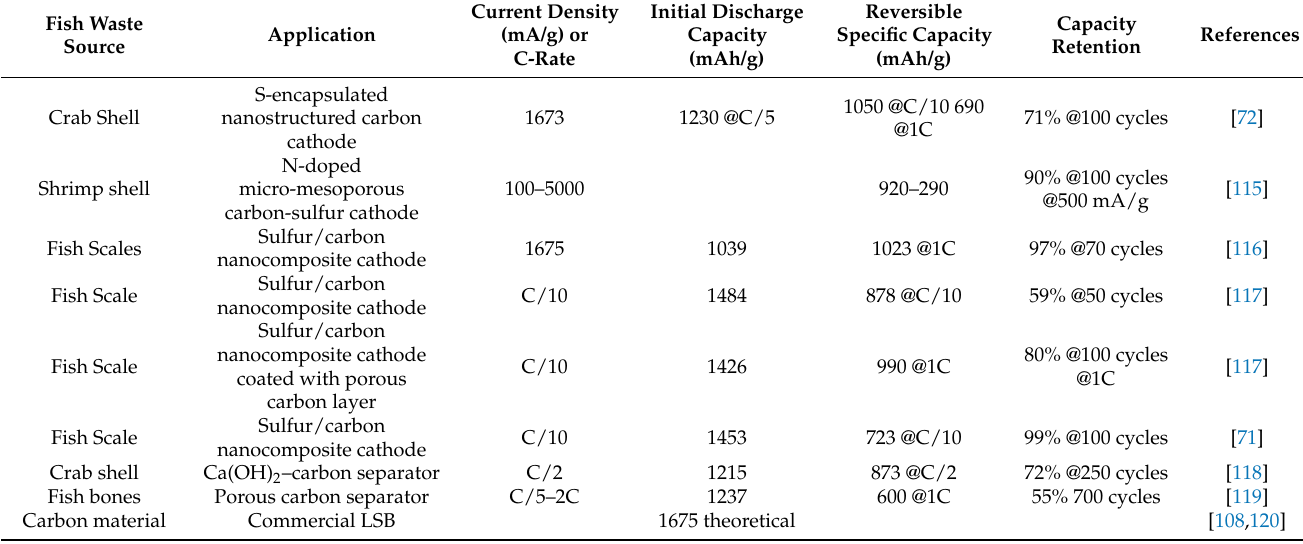
Table 3. Performance of porous carbon-based materials for LSBs obtained from fish industry